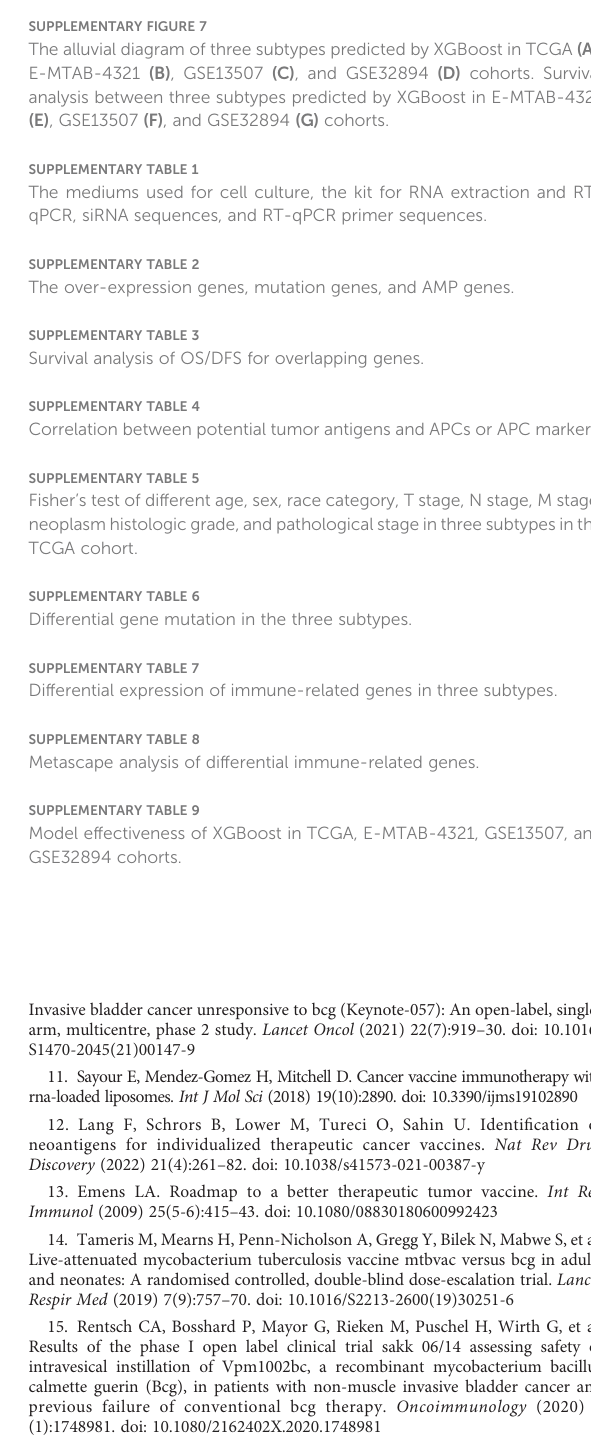
SUPPLEMENTARY FIGURE 6 Example R script of using ” immcluster. ”